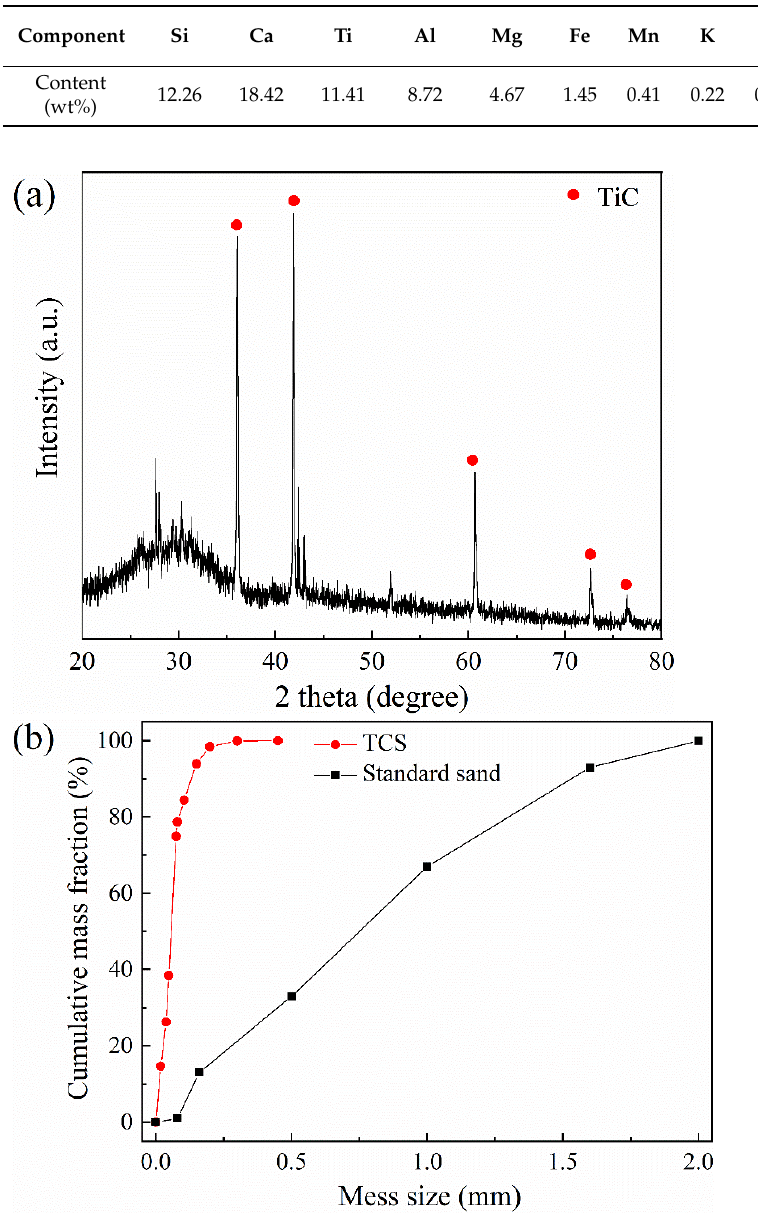
Figure 2. ( a ) XRD pattern of TCS, ( b ) comparison of grain size cumulative curves for TCS and standard sand.